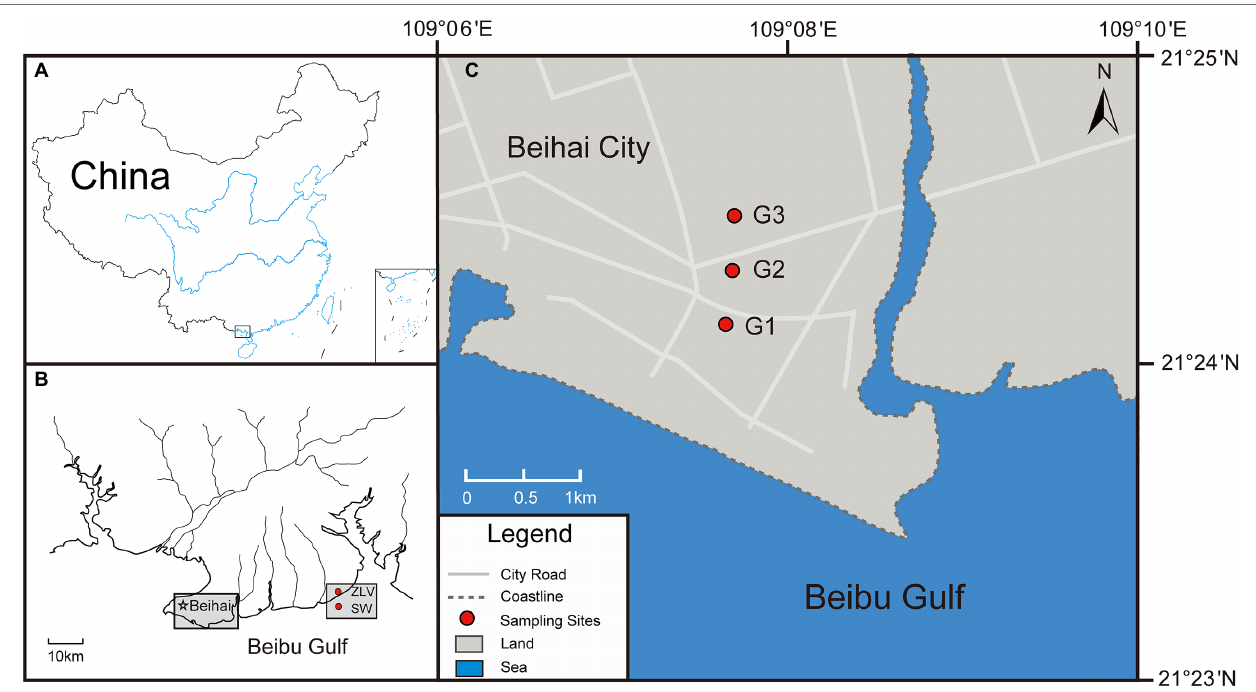
FIGURE 1 | Schematic diagram of the study area and sampling location. (A) The black rectangle in the lower part of the plot indicates the location of Beihai City. (B) The southern coastal area of Beihai City and the location of the three monitoring sites involved in this study, the location of seawater (SW) collected from the Beibu Gulf and the location of groundwater discharge site (ZLV-CI) from the Zhuoluo beach. (C) The location of the three monitoring sites (G1, G2 and G3) illustrated in (B)